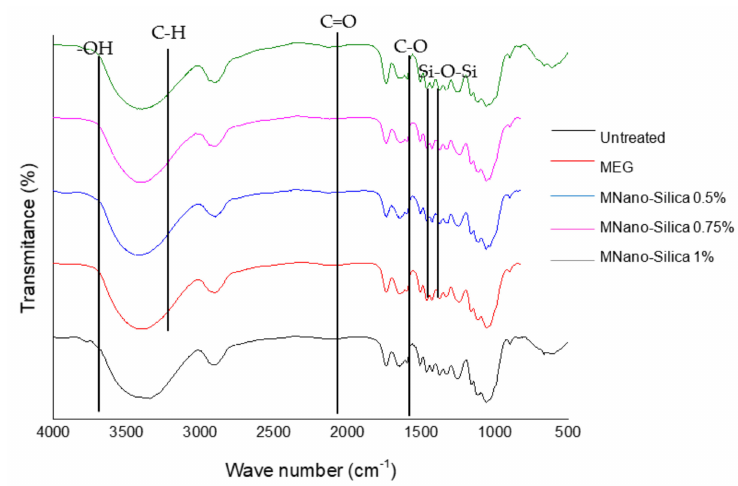
Figure 4. FTIR analysis of sengon wood after impregnation